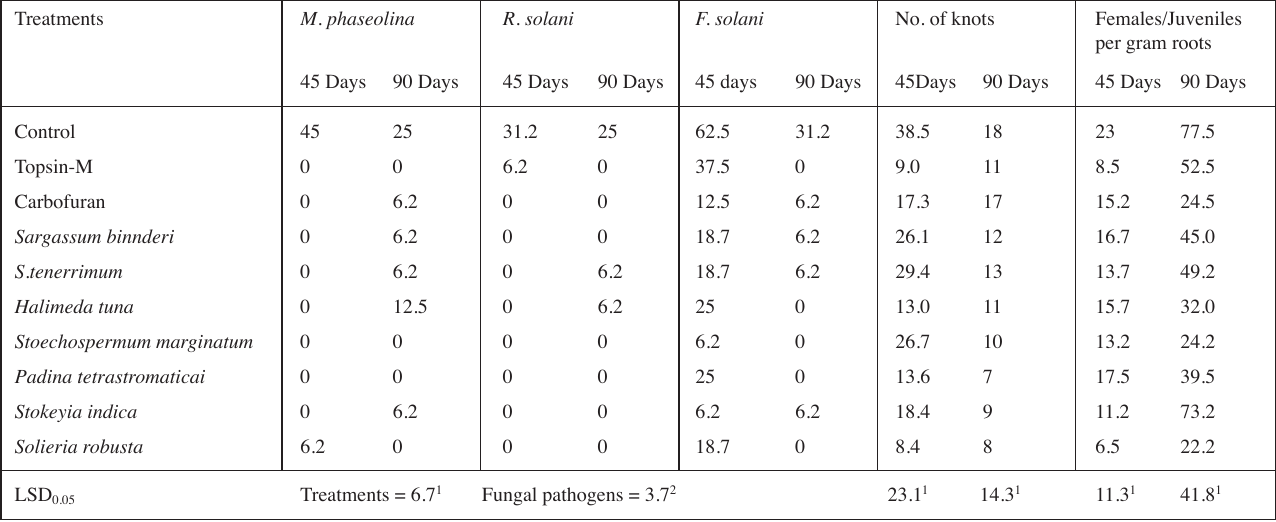
Tab. 5: Effect of seaweeds on the infection of root rotting fungi Macrophomina phaseolina, Rhizoctonia solani, Fusarium solani and root knot nematode Meloidogyne javanica on pepper roots in field experiment.